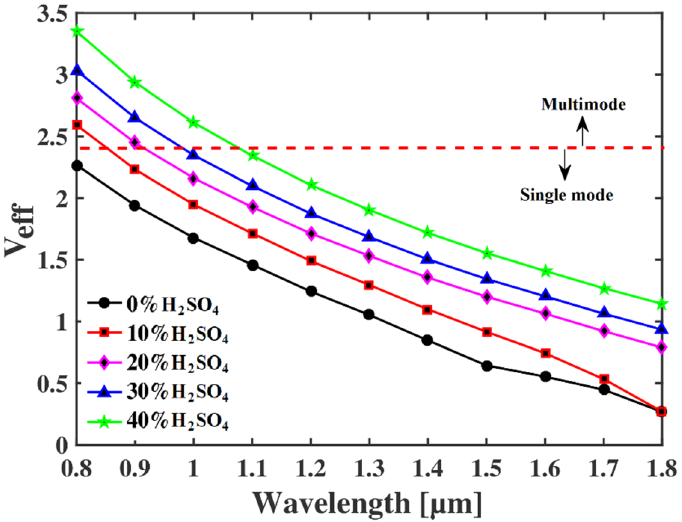
Figure 8. V eff of the proposed sensor for different operating wavelengths.